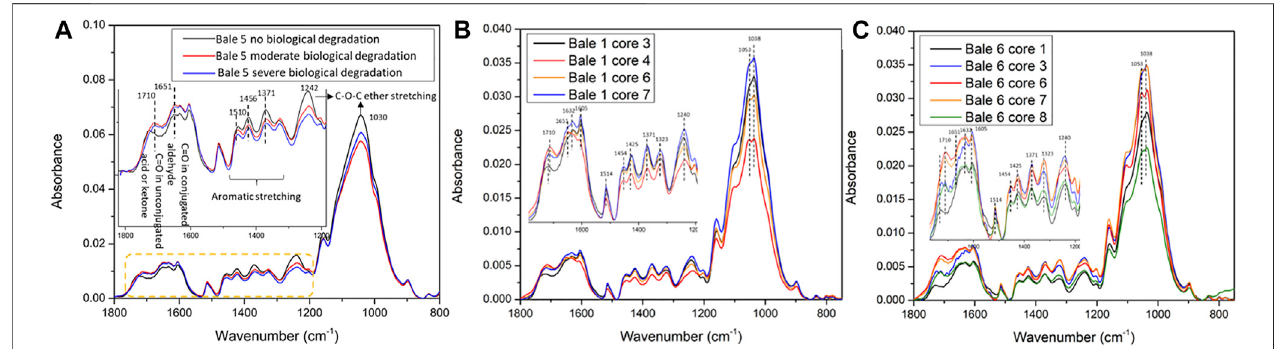
FIGURE 5 | FT-IR from samples from across a range of degradation states (A) Bale 5, (B) Bale 1, and (C) Bale 6.